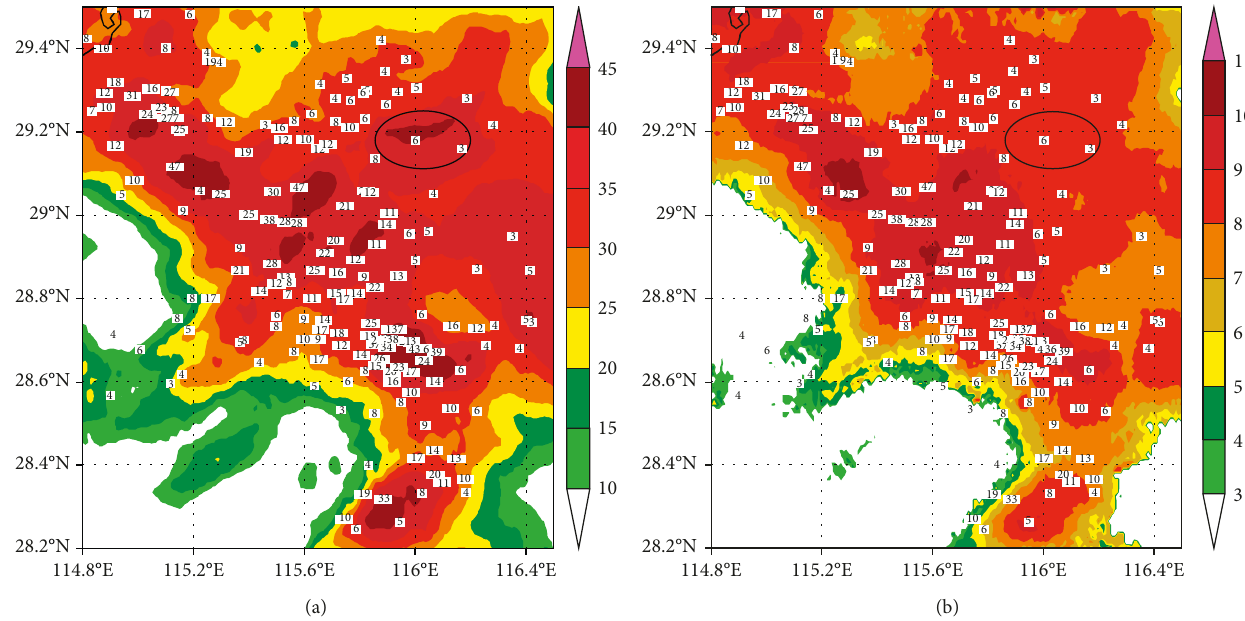
Figure 5: (a) CR (unit: dBZ) and (b) ET (unit: km) in the black rectangle in Figure 4 at 2200 UTC 1 June 2016. Digits show the 1-hour precipitation (mm) observed by rain